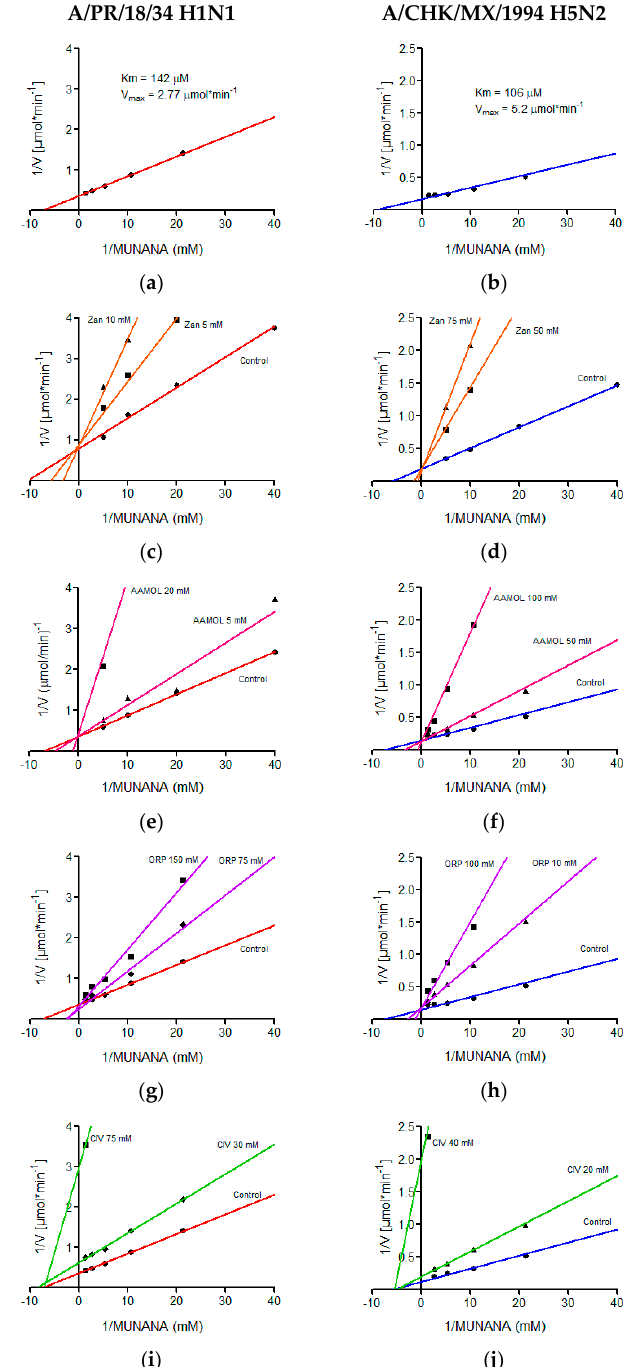
Figure 6. Lineweaver-Burk diagrams of two influenza A virus strains. Panels ( a ), ( c ), ( e ), ( g ) and ( i ) report the kinetic analyses of viral strain A / PR / 18 / 34 H1N1, while panels ( b ), ( d ), ( f ), ( h ) and ( j ) report the kinetic analyses of viral strain A / CHK / MX / 1994 H5N2. Panels ( a ) and ( b ) show treatments with MUNANA as a substrate. Panels ( c ) and ( d ) present treatments with zanamivir; panels ( e ) and ( f ) with AAMOL; panels ( g ) and ( h ) with ORP; and panels ( i ) and ( j ) with CIV, respectively. The GraphPadPrism 6.04 program was used to determine values of the inhibition constant (Ki) for the molecules